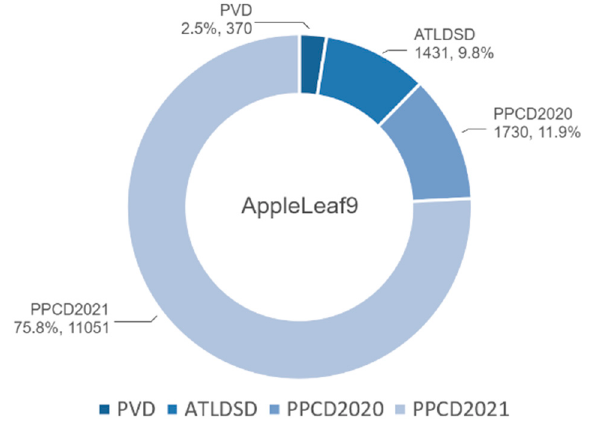
Figure 1. Distribution of image sources in AppleLeaf9.